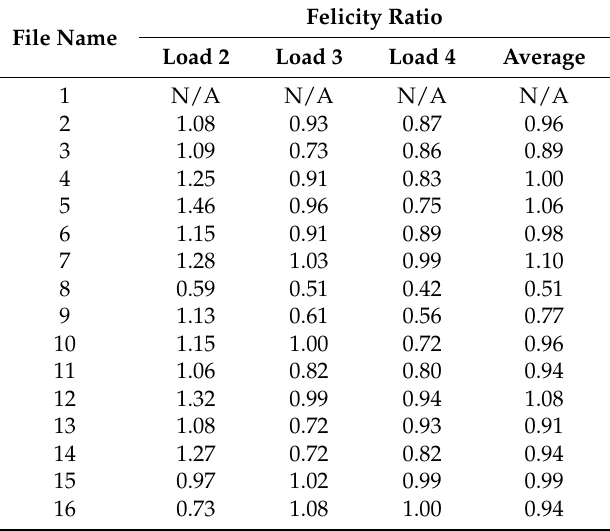
Figure 3. Sample AE activity observed during four separate spar tests. ( a ) Test 14, ( b ) Test 8, ( c ) Test 10, and ( d ) Test 4. Table 2. Felicity ratio values calculated based on the four applied loading cycles.